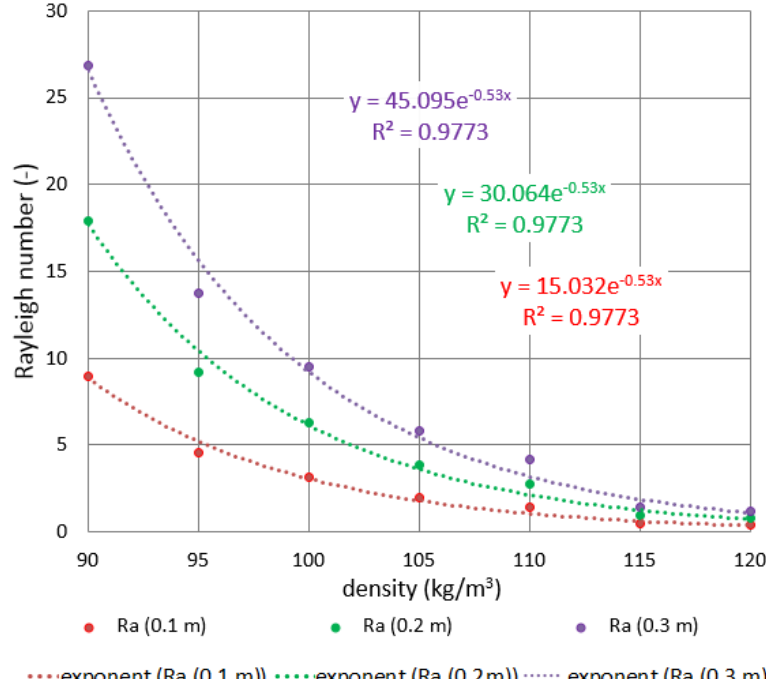
Figure 8. Dependence of the Rayleigh number on the density and thickness of thermal insulation made of hemp shives.